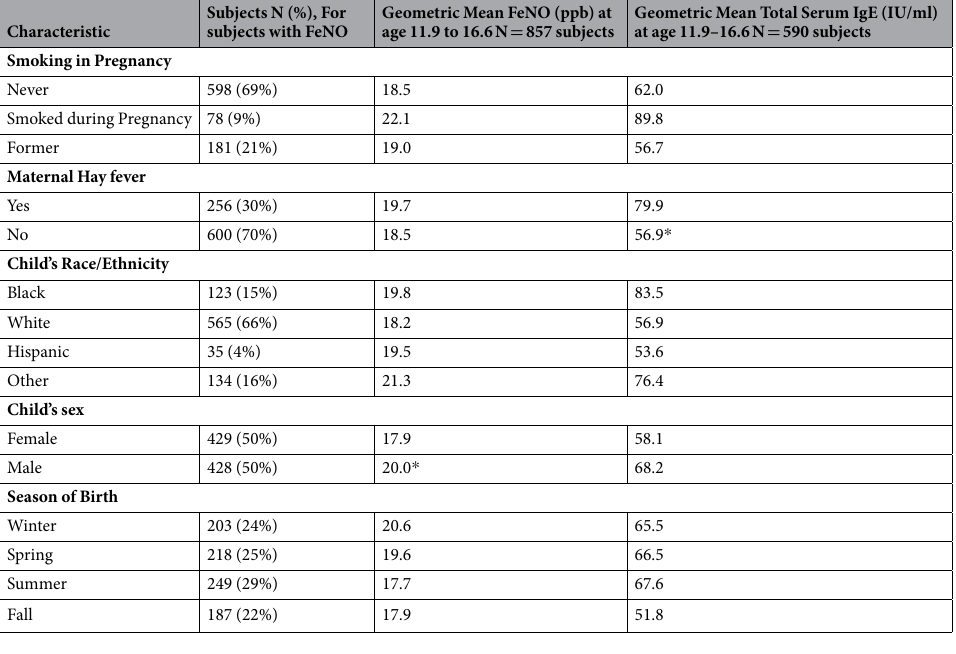
Table 1. FeNO and Total Serum IgE levels in Adolescence by Participant Characteristics. * p value < 0.05 for